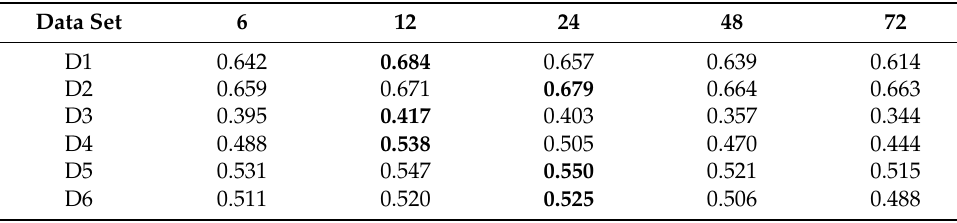
Table 4. Variance of the F-measure performance with the variance of the parameter l . Data